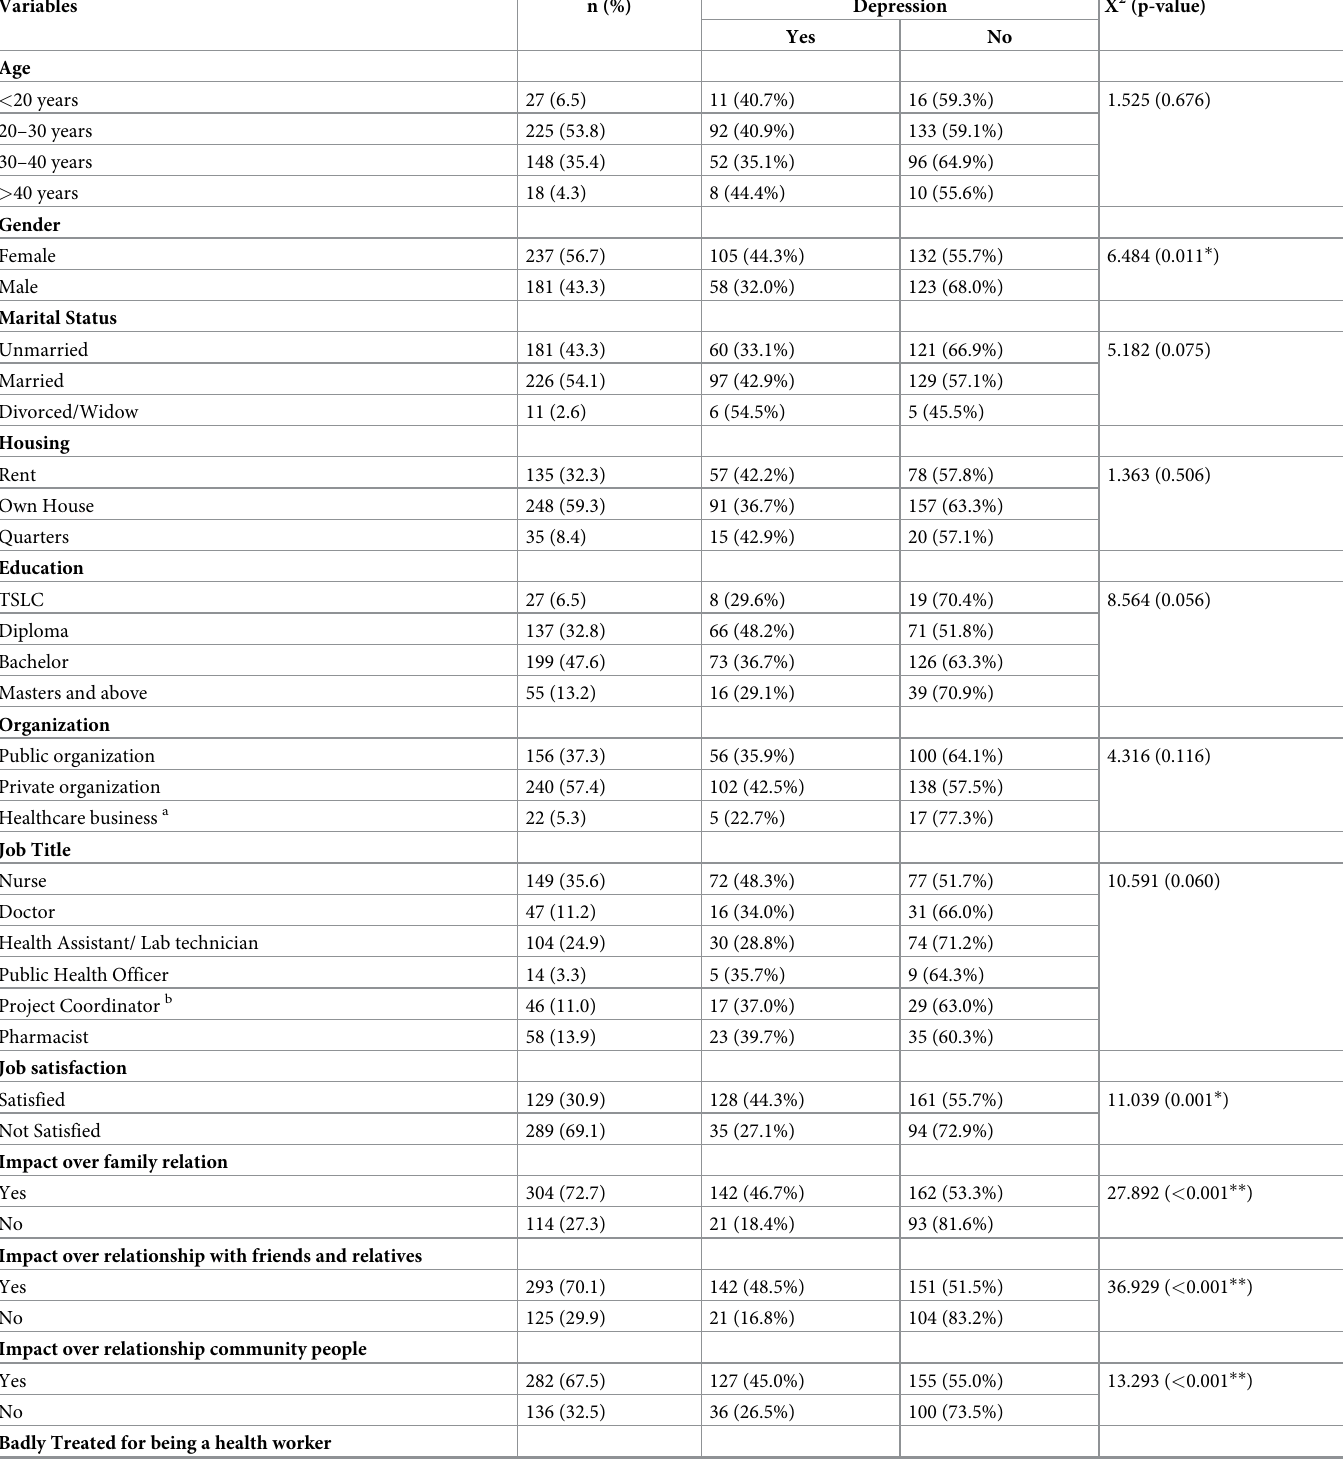
Table 6. Factors associated with depression among health